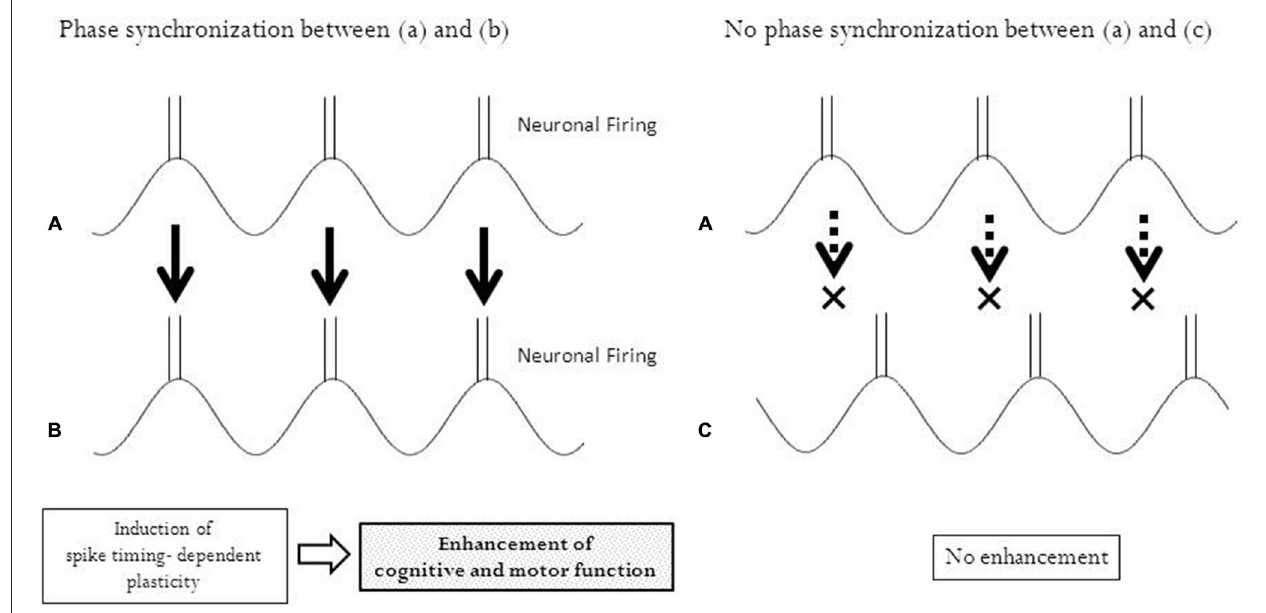
(C) with different timing of neuronal firing does not induce any